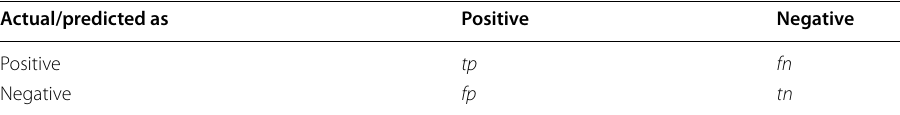
Table 2 Confusion matrix for two-class classification Actual/predicted as Positive Negative Positive tp fn Negative fp